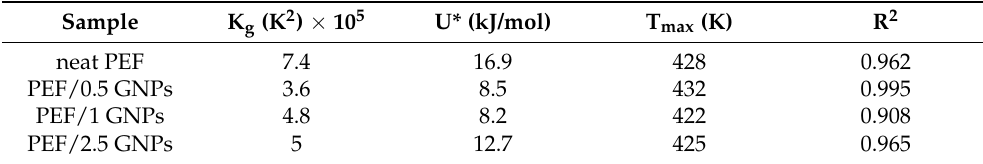
Table 2. Values of Kg and U*, derived by the H-L fitting to the crystallization growth rate G of the neat PEF and PEF/GNP